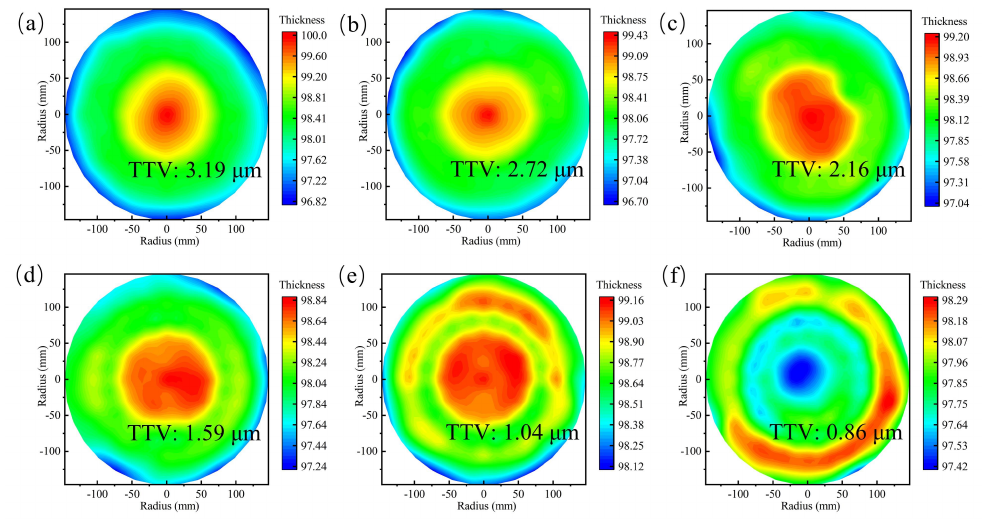
Figure 16. The TTV measurement results. ( a ) The original TTV just after the chuck table dressing; ( b – f ) TTV compensation results by adjusting α angle.